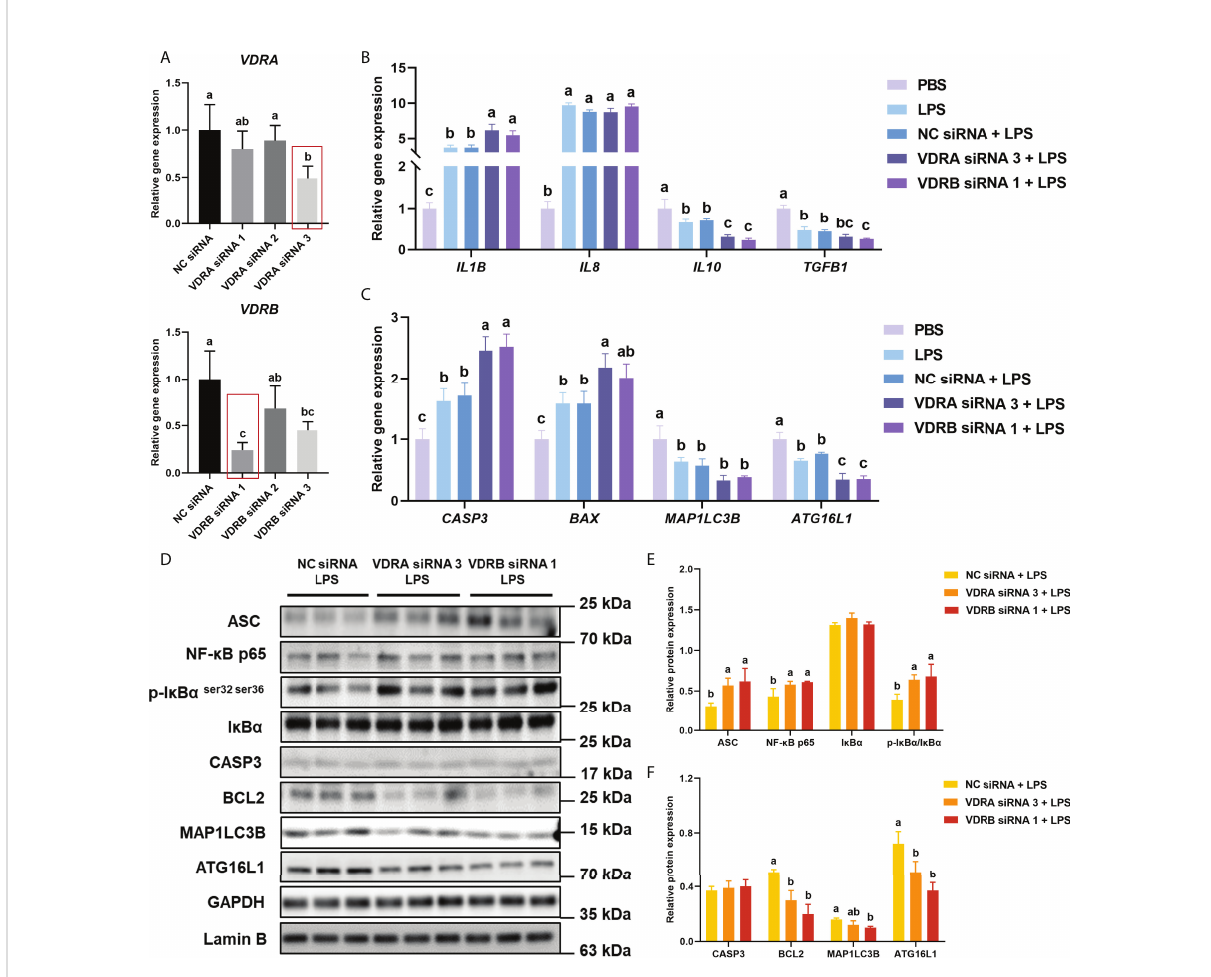
FIGURE 3 VDR knockdown in vivo on in fl ammation, apoptosis, and autophagy in the intestine. (A) The relative mRNA expression level of VDRA&B in the intestine treated with VDRA&B siRNAs. (B) The mRNA expression levels of IL1B , IL8 , TGFB1 , and IL10 . (C) The mRNA expression levels of CASP3 , BCL2 , BAX , MAP1LC3B , and ATG16L1 . (D-F) The level of ASC, intranuclear NF- k B p65, total I k B and phosphorylated I k B, CASP3, BCL2, MAP1LC3B, and ATG16L1 were analyzed and quantitated by western blot. The blots of ASC, I k B a , p-I k B a ser32 ser36 , CASP3, BCL2, MAP1LC3B, and ATG16L1 were used for GAPDH loading control, while the blot of NF- k B p65 was used for Lamin B loading control. Error bars of columns denote SD (n = 3), and columns with different letters above them are signi fi cantly different ( P <